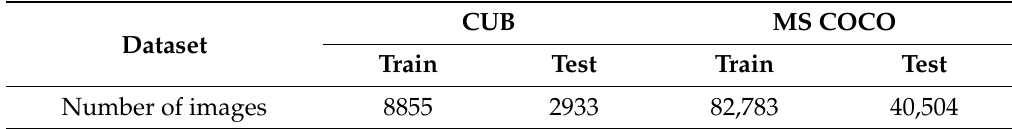
Table 1. The basic information for the CUB and MS COCO datasets.